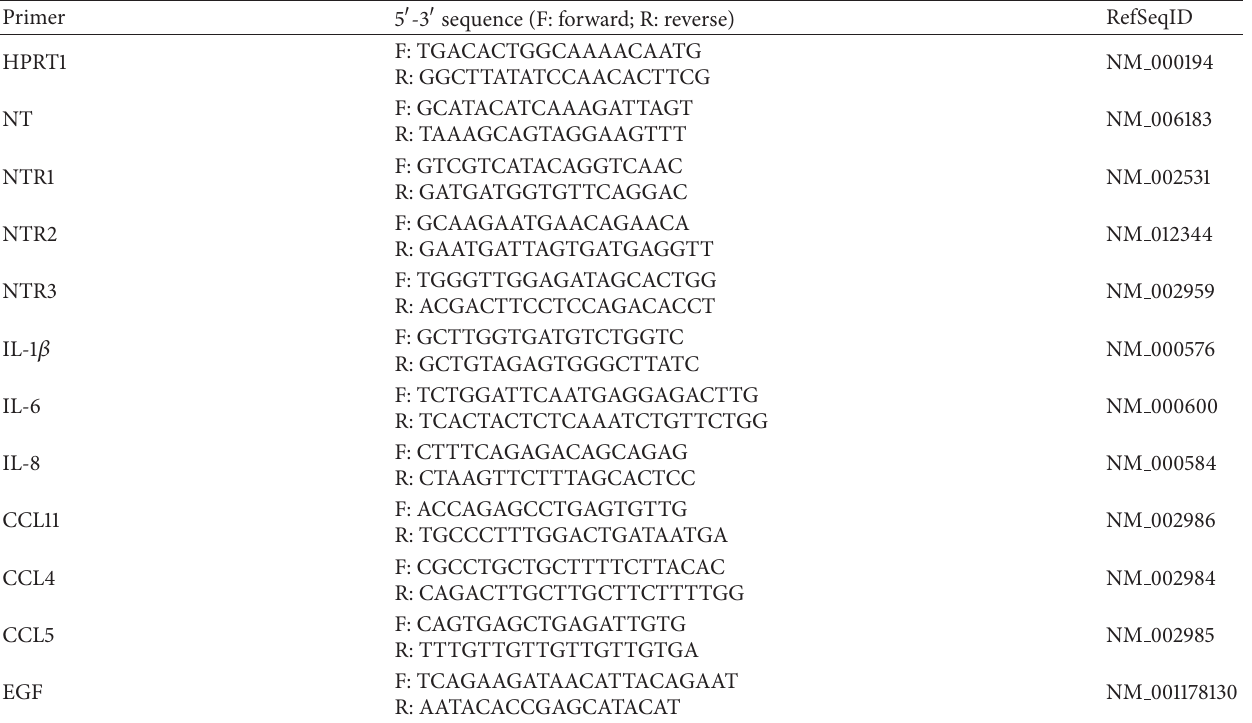
Table 1: Primer sequences for targeted